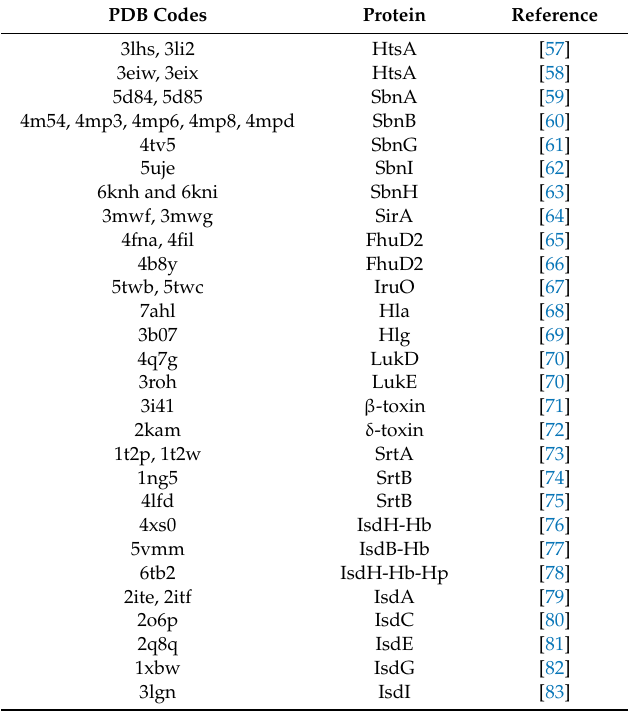
Table 1. Protein Data Bank (PDB) accession codes of proteins involved in iron acquisition by Staphylococcus